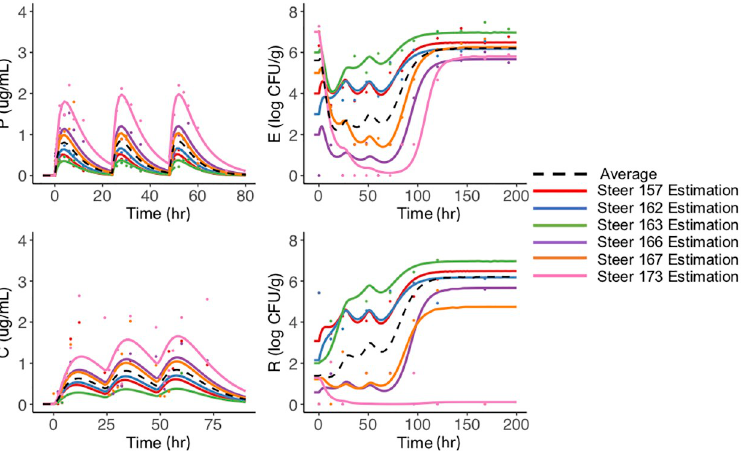
Fig 3. Low dose steer dynamics. Prediction of the low dose treatment group. Estimation of the concentration of antimicrobial drugs in the plasma, P , colon, C and estimation of the amount of the total E. coli and E. coli above the ECOFF in the feces. Each steer is represented by the same color for model predictions (lines) and corresponding data (dots). The median population estimate for each compartment is the black dashed line.